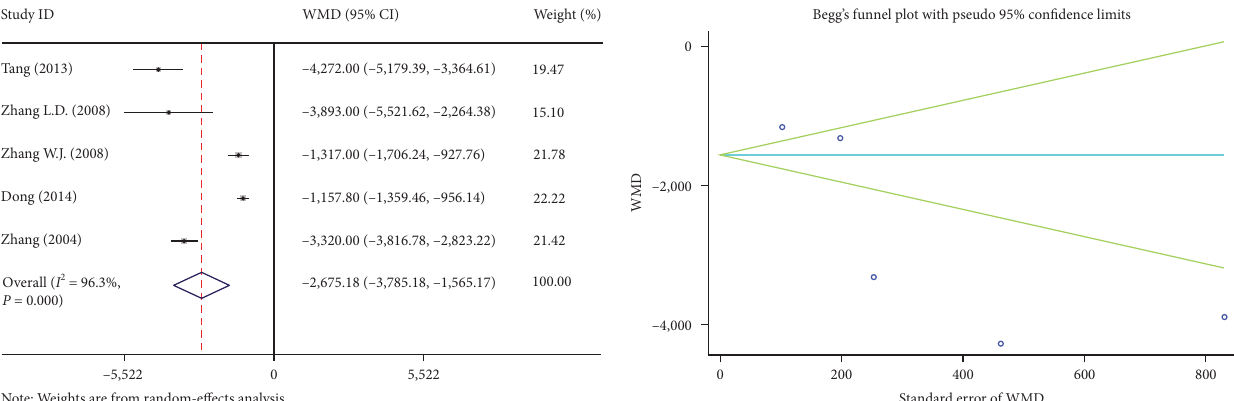
F IGURE 5: Forest plot and funnel plot of the hospital expenses between the primary suture group and the T-tube drainage group.